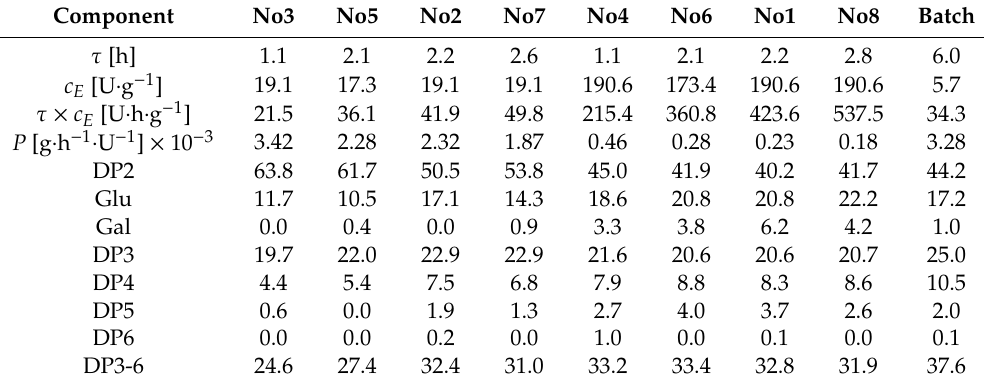
Table 1. Steady-state saccharides’ composition in w / w % for short-term EMR runs. The composition obtained for batch process (at 6 h) is indicated for comparison purpose.